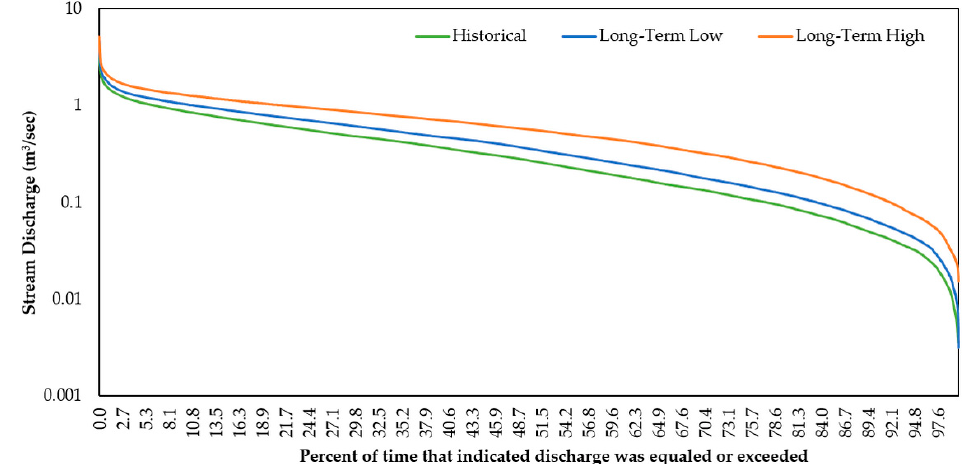
13 of 24 Table 7. Average stream temperature and streamflow simulated with climate change variables for ( a ) Beaver River, ( b ) Queen River and ( c ) Cork Brook. High and low CO 2 emission scenarios projected for short (2010–2039), medium (2040–2069) and long-term (2070–2099). Unchanged historical results included for reference. Scenario